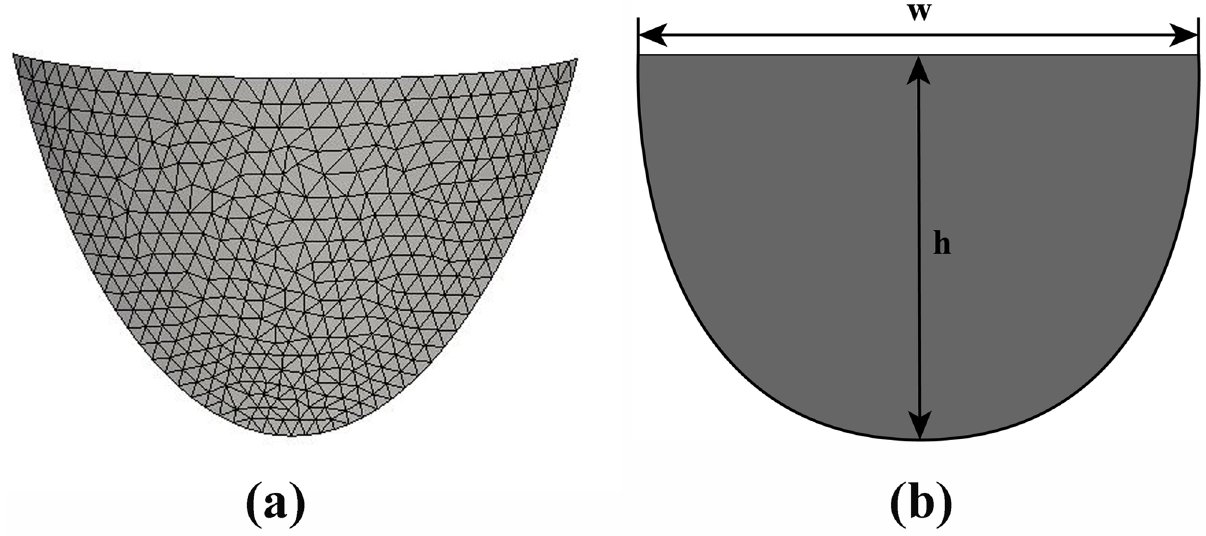
Fig 4. (a)The leaflet shape shown in 3D (b)The leaflet shape shown “laid flat” in 2D.